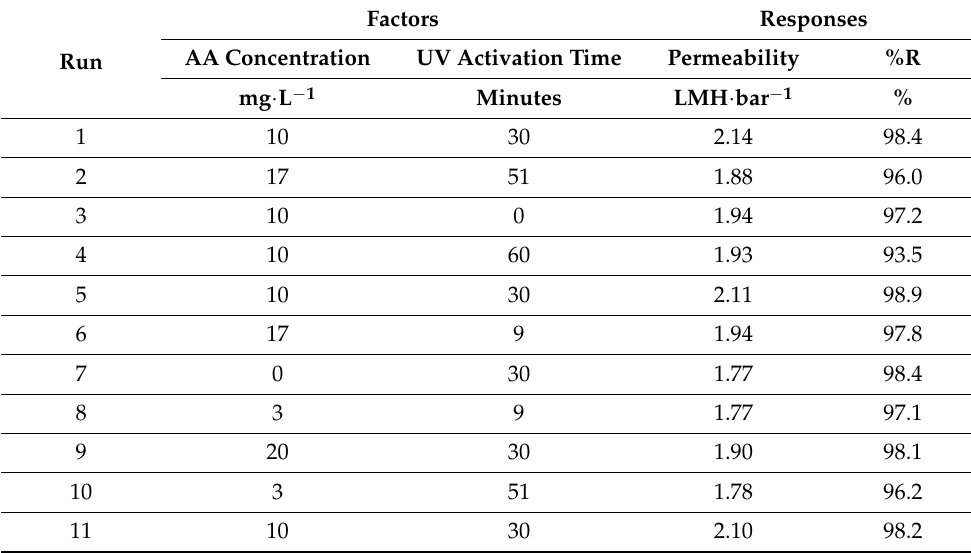
Table 4. Experimental sets with actual factors in RSM and